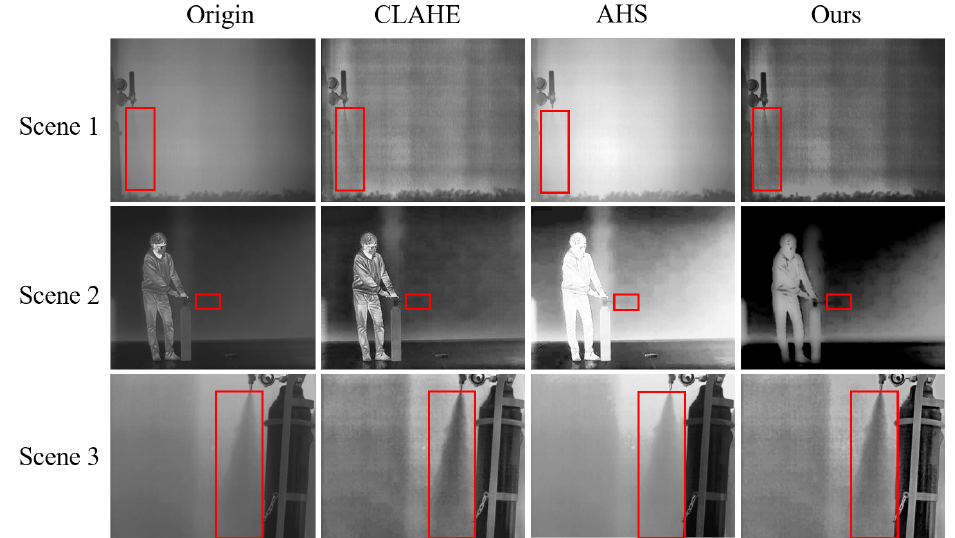
Figure 4. Comparison of infrared image-enhancement algorithm